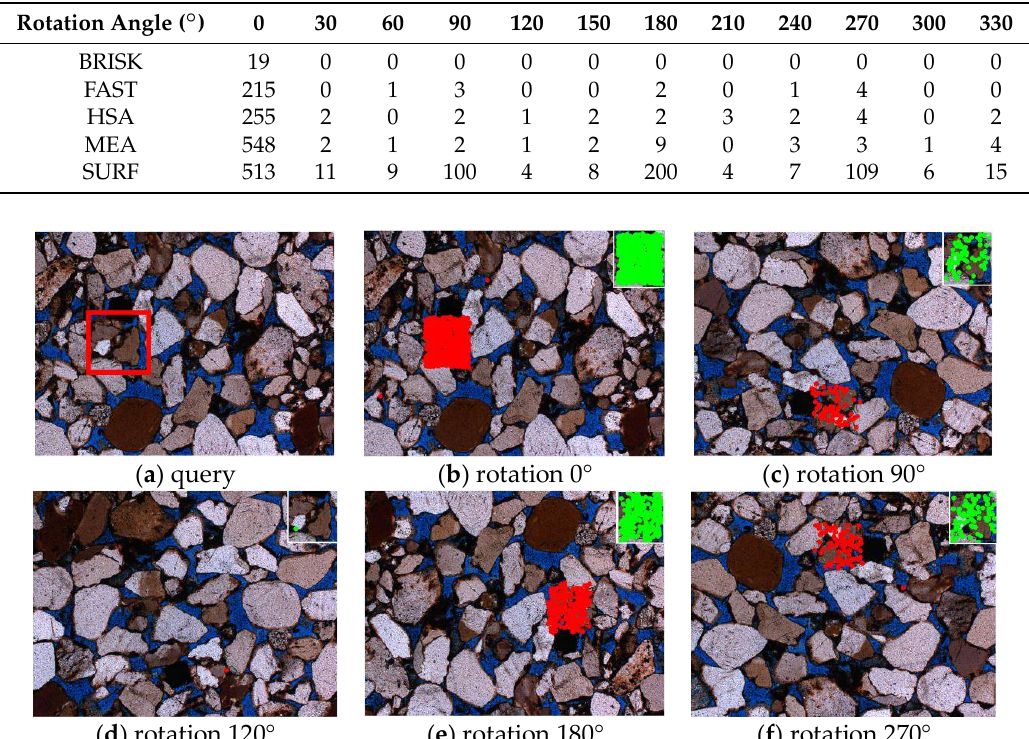
Figure 4. Effects of the detection of interest points between non-rotated query (green points) and microscope rotated frames (red points) with the SURF method, sandstone from Solec.